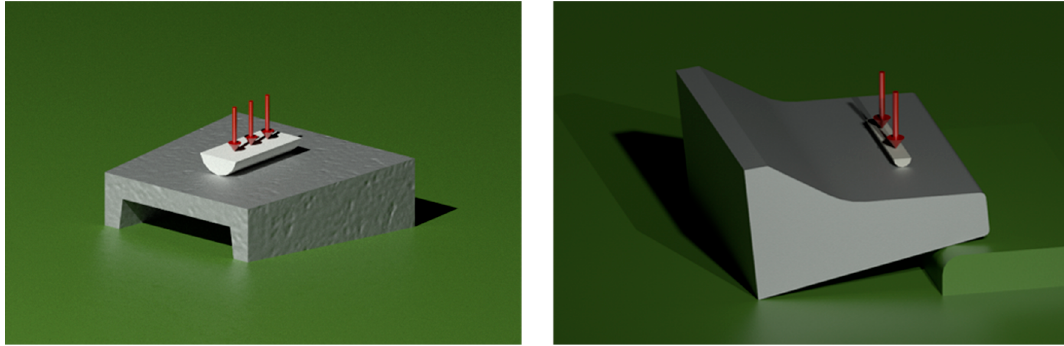
Figure 3. Precast element characterization (concrete ditches left, New Jersey barriers right).